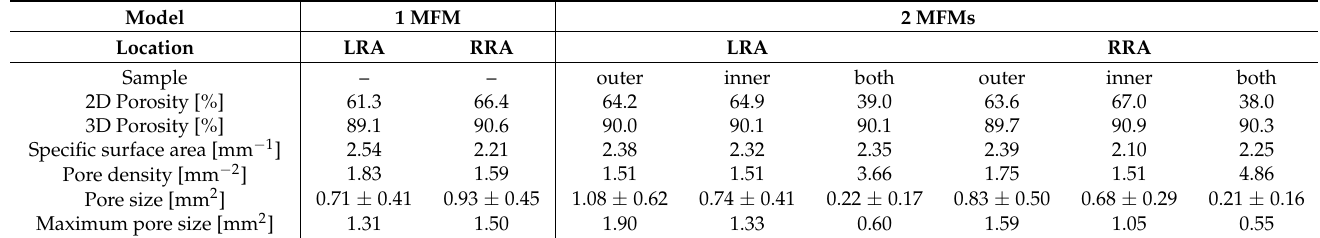
Figure 3. MFM devices microstructure analysis in front of the RAs. ( a ) single and ( b ) overlapped case. Micro-CT projection (center) and reconstructed stent geometry in trimetric, ZX and ZY views. Flow crosses the MFM devices through axis Y. Color code for the overlapped case is green and red for outer and inner MFM, respectively. Size of the cropped geometry is 5 × 5 mm². Table 1. Microstructural parameters evaluated on the extracted MFM geometries. Pore size values are reported as weighted mean ± weighted standard